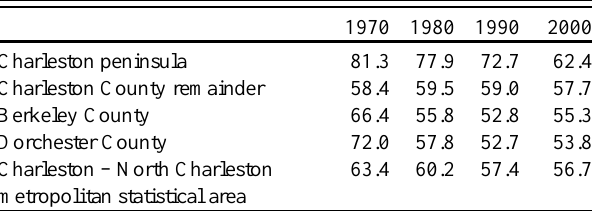
Table 3. Percentage of population born in South